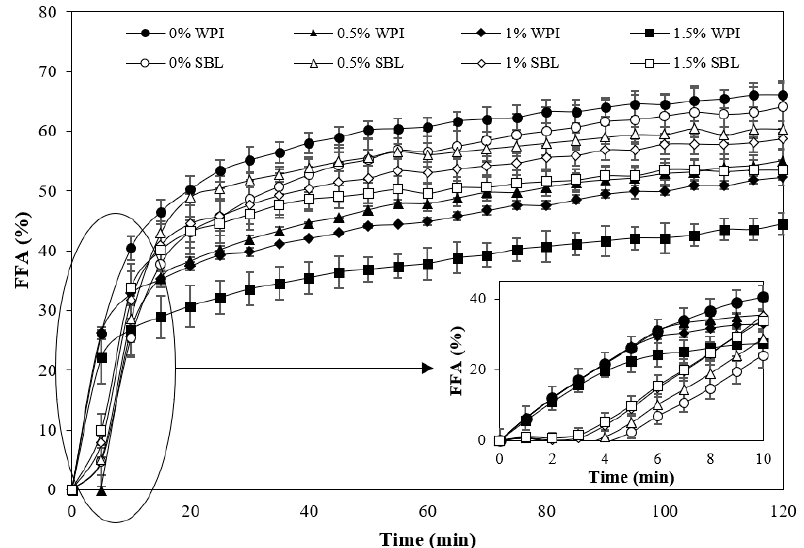
Figure 6. Free fatty acids (FFA) release during the intestinal in vitro digestion of curcumin-loaded nanoemulsions stabilized with lecithin (SBL) or whey protein isolate (WPI) and different sodium alginate concentrations (0, 0.5, 1 and 1.5%).